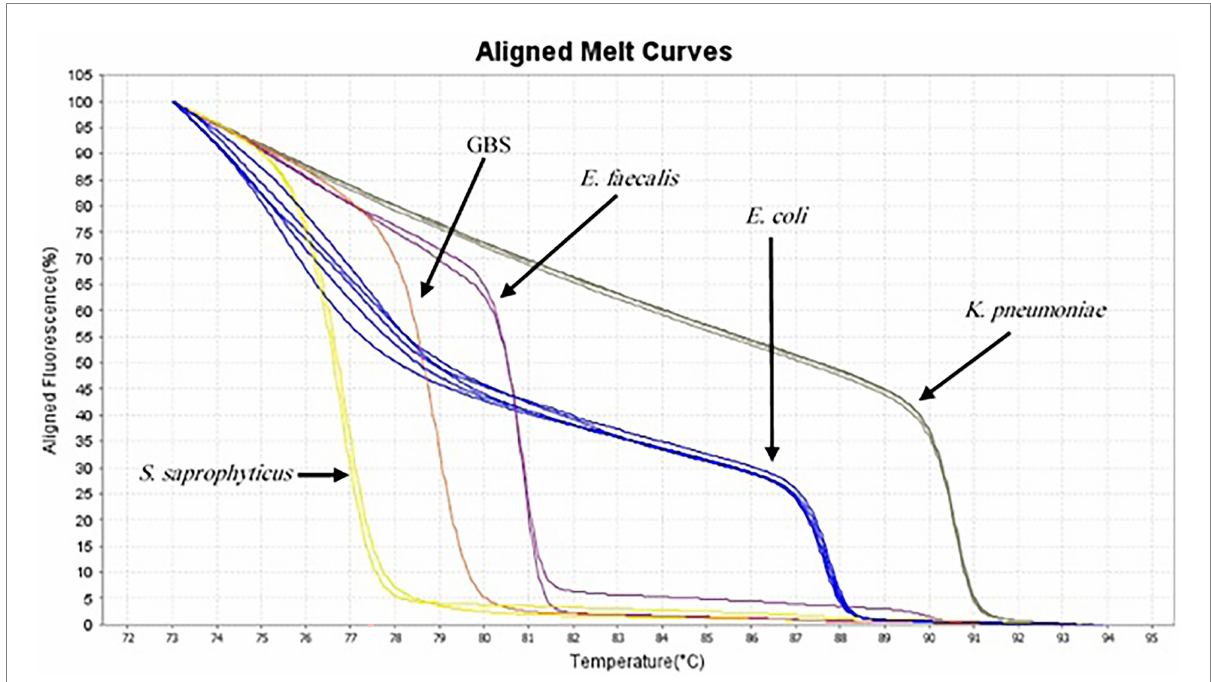
FIGURE 2 Aligned melt curves of five different species generated from urine samples (as described in the legend to Figure 1) from the lowest Tm to highest.